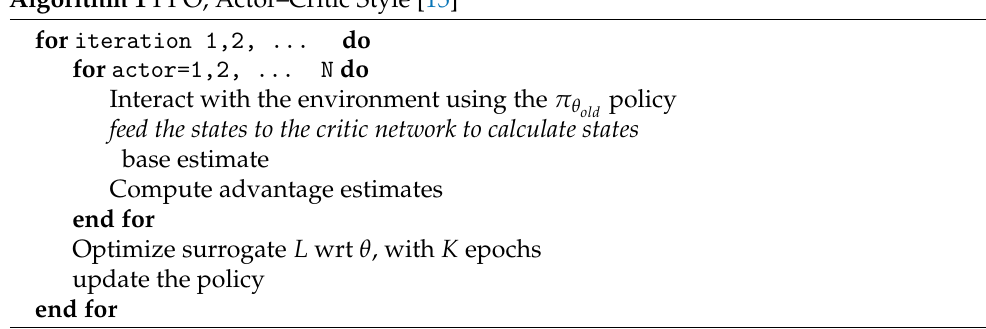
Algorithm 1 PPO, Actor–Critic Style